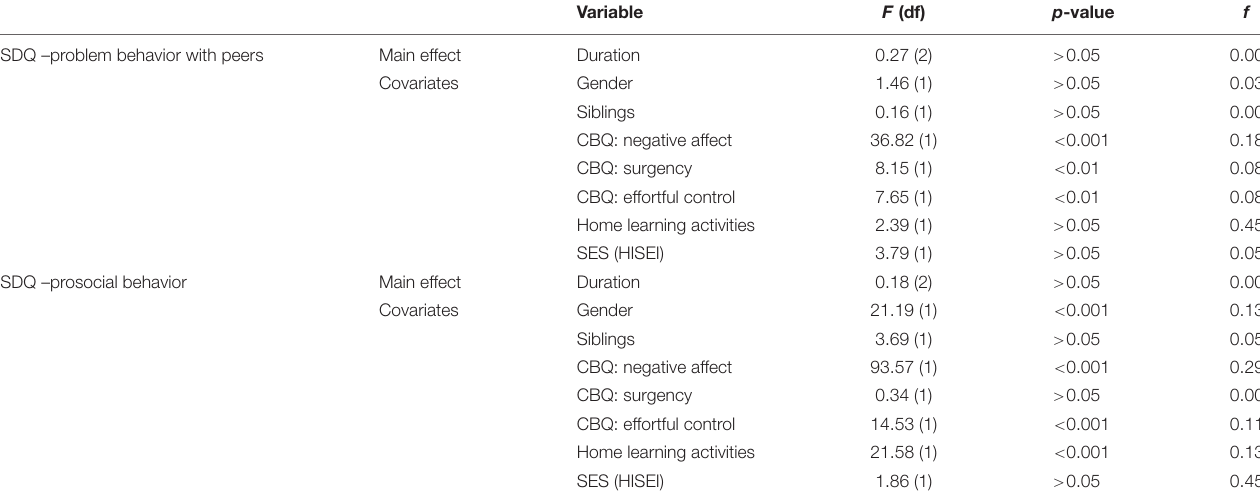
Variable F (df) p